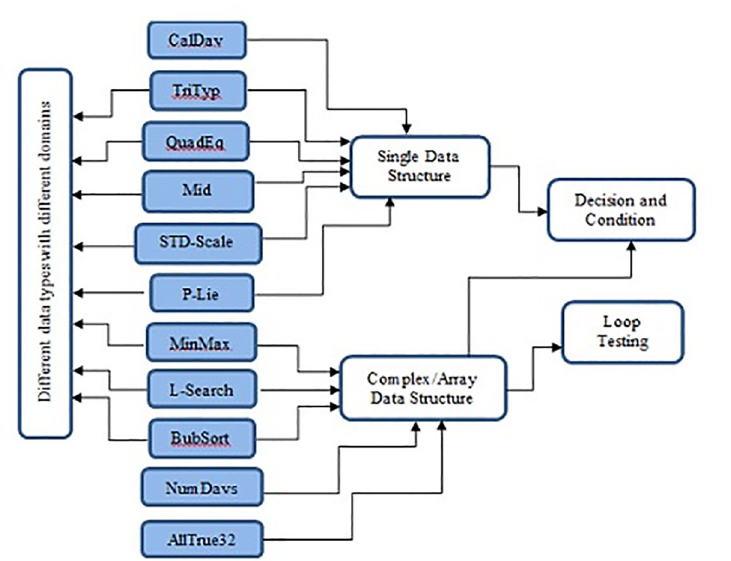
Fig 4. Classification of the benchmarks